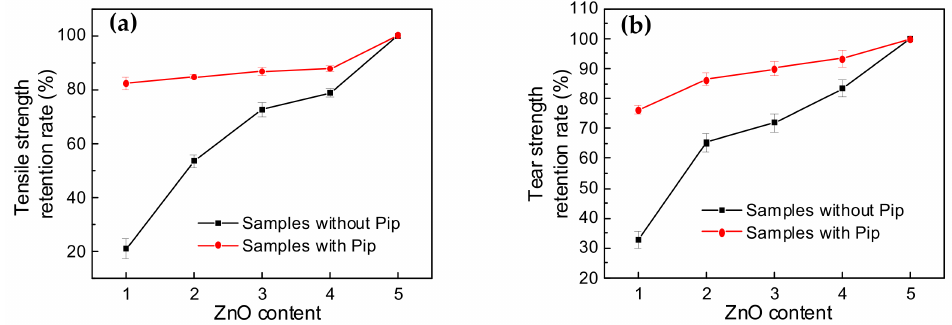
Figure 5. Changes in mechanical properties with low ZnO content. ( a ) Comparison of tensile strength retention rate with different ZnO contents for the samples with and without phase transfer agent. ( b ) Comparison of tear strength retention rate with different ZnO contents for the samples with and without phase transfer agent.